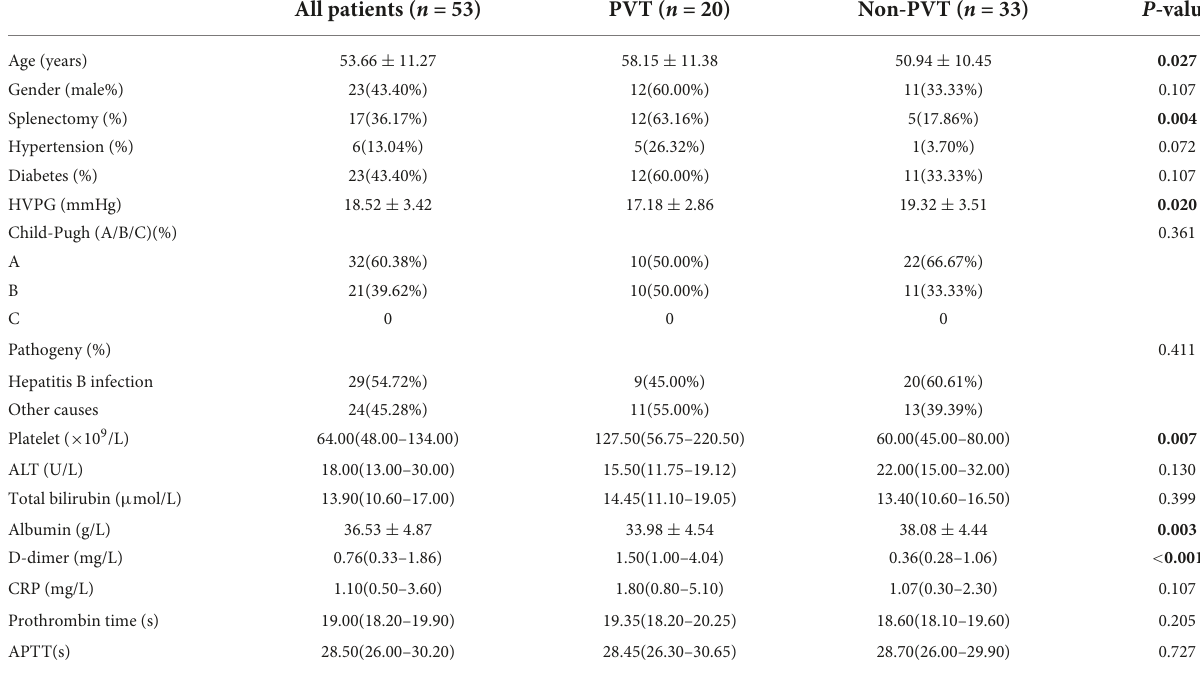
TABLE 1 Demographic characteristics and laboratory exanimations of cirrhotic patients.